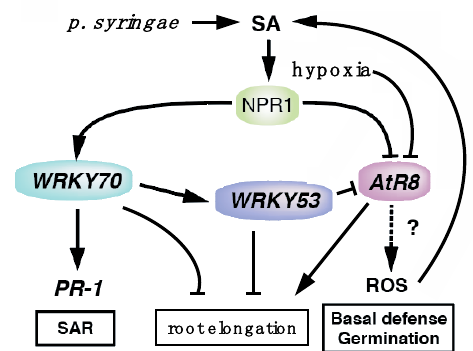
Figure 9. Proposal working model that illustrates the interaction among the AtR8 long non-coding RNA (lncRNA) and WRKY network with SA-dependent defense signaling. AtR8 lncRNA might regulate the basal defense system independent from SAR. The AtR8 lncRNA potentially exhibits an inverse correlation to the WRKY70 gene with SA-dependent defense signaling and root elongation. WRKY70 is upstream in the WRKY signaling cascade, while AtR8 lncRNA is repressed by WRKY53 . The NPR1 might be a key regulator for mutual regulation between AtR8 lncRNA and WRKY70 genes.